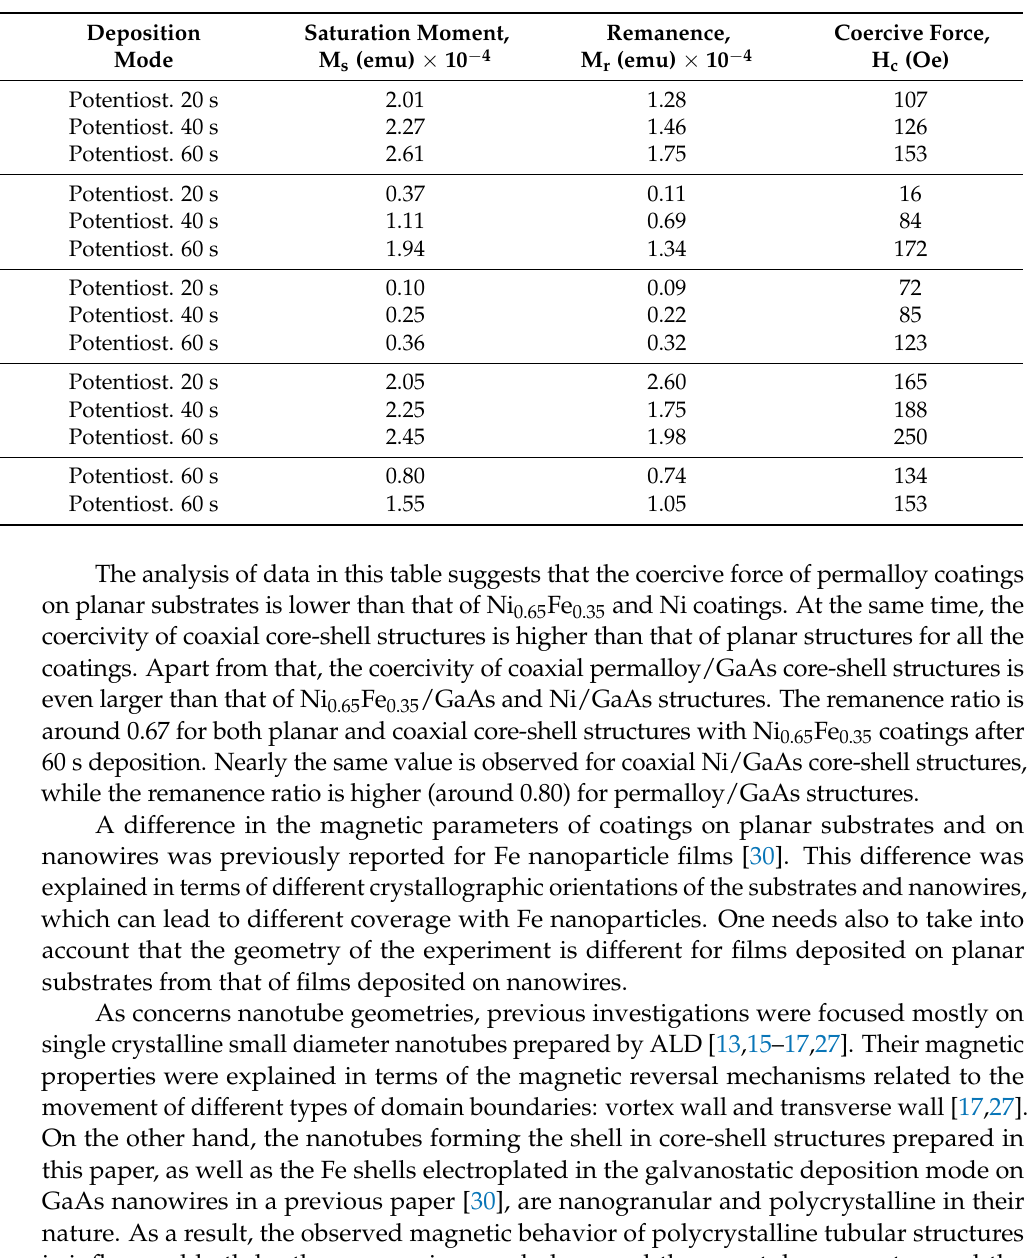
Table 2. Saturation moment, remanence, and coercive forces for electrochemically deposited NiFe and Ni coatings on planar substrates and GaAs nanowires samples for VSM